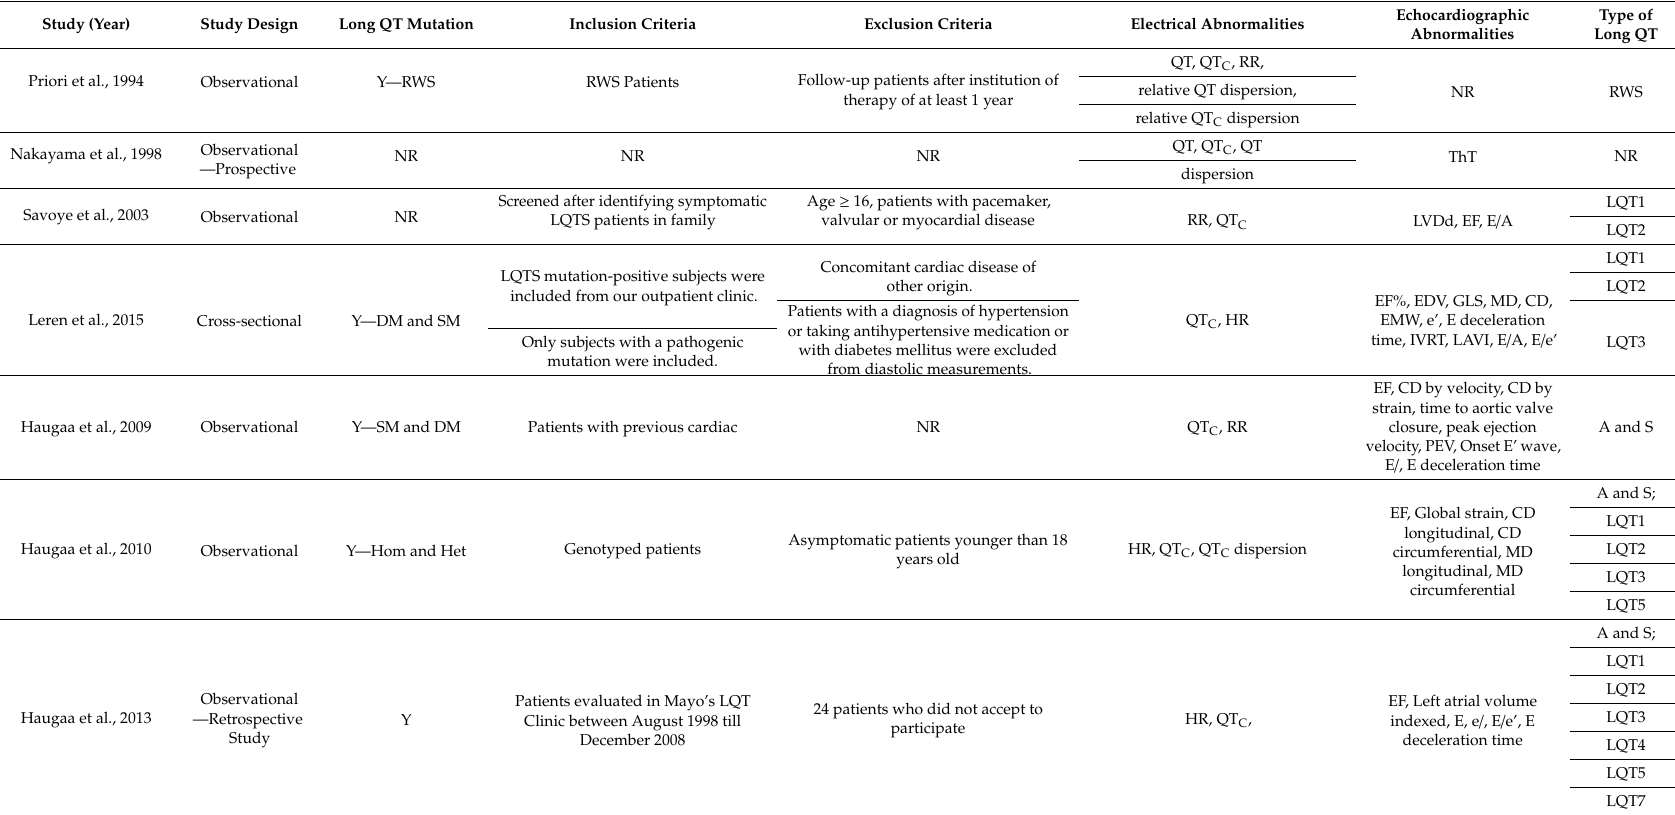
Table 1. Main characteristics of studies included in the